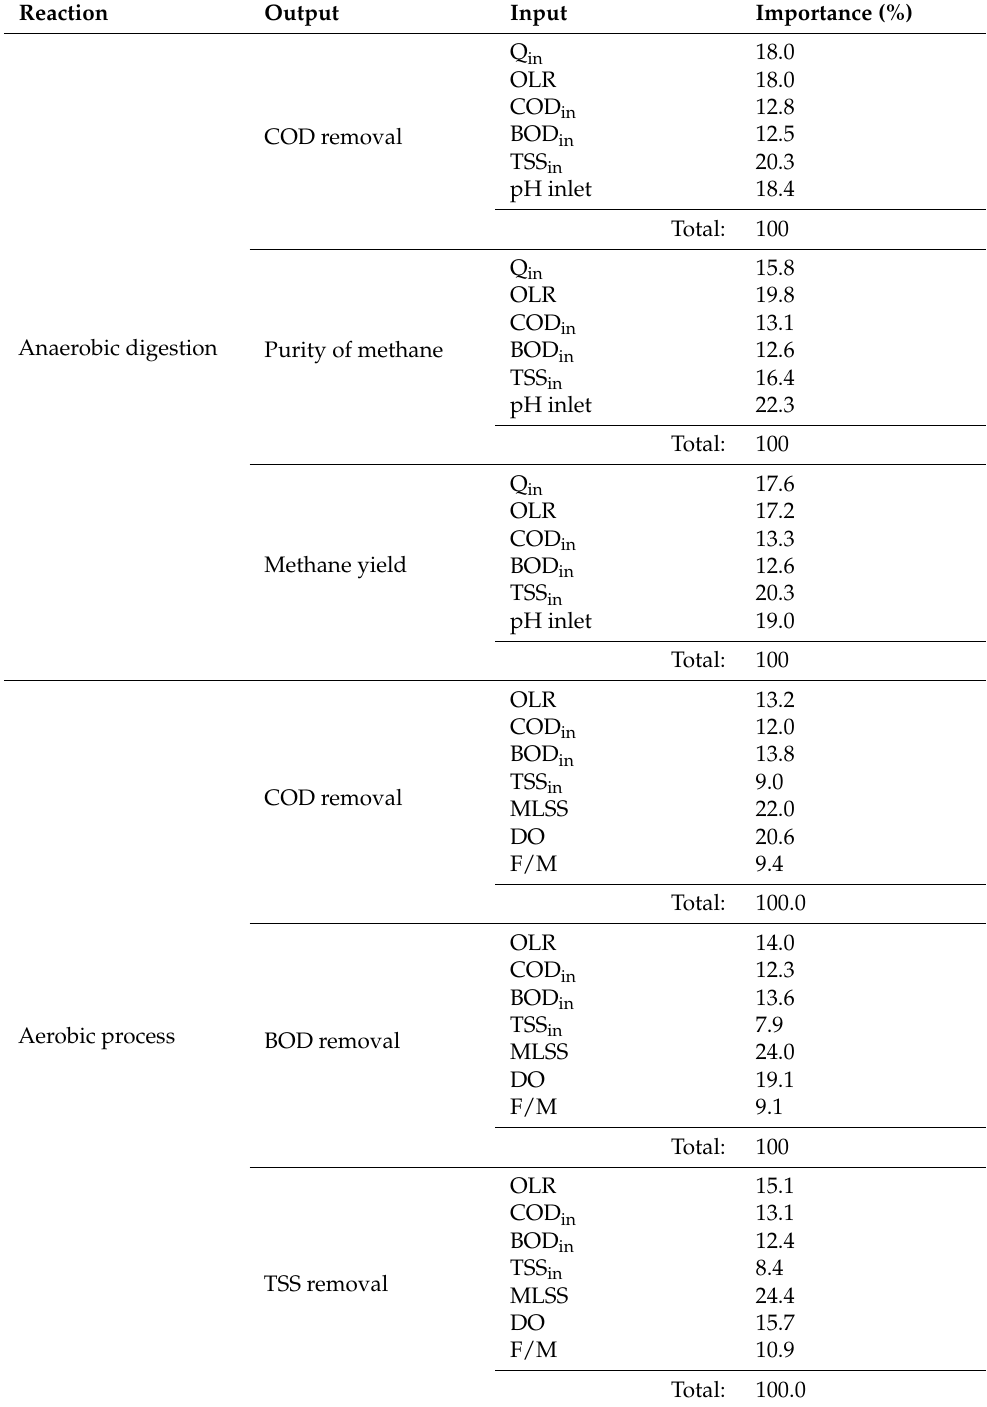
Table 3. Relative importance of input variables for anaerobic process using Garson